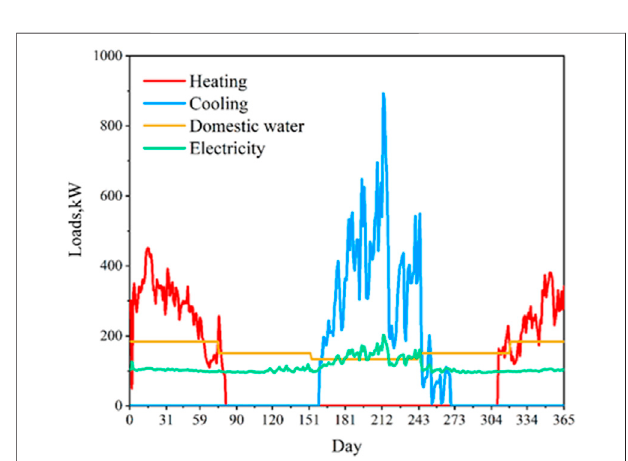
FIGURE 3 | Daily solar radiation.